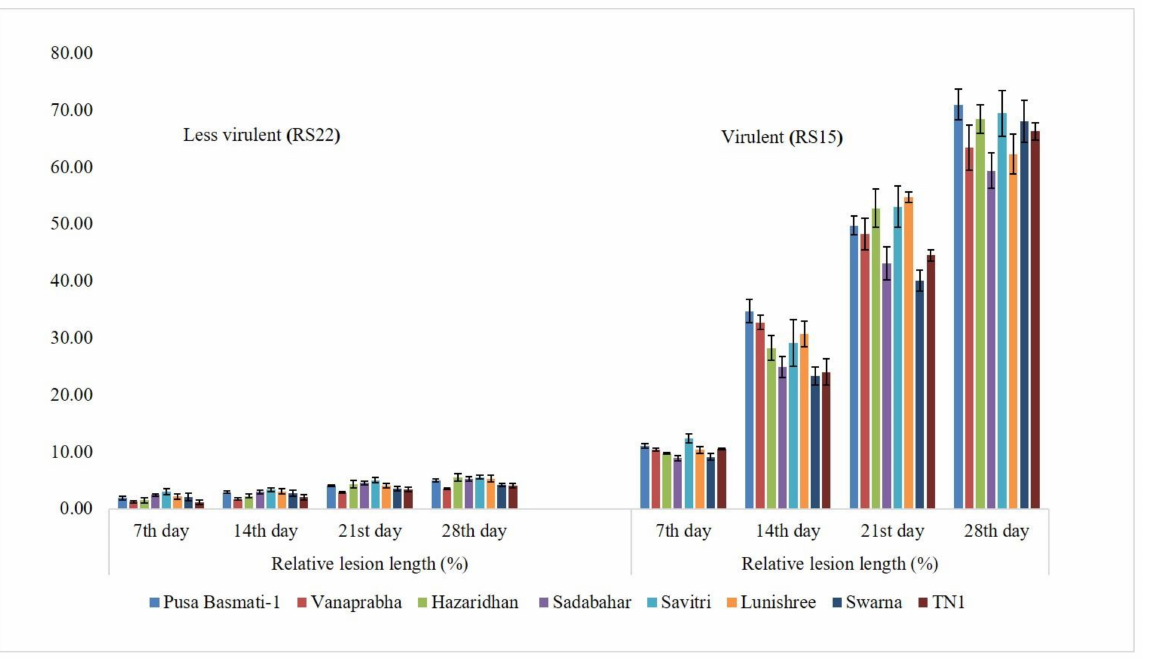
Figure 2. Relative Lesion Length % of RS22 and RS15 on different rice genotypes. Vertical bars indicate the standard error of three replications. Analysis of variance was performed through DMRT with